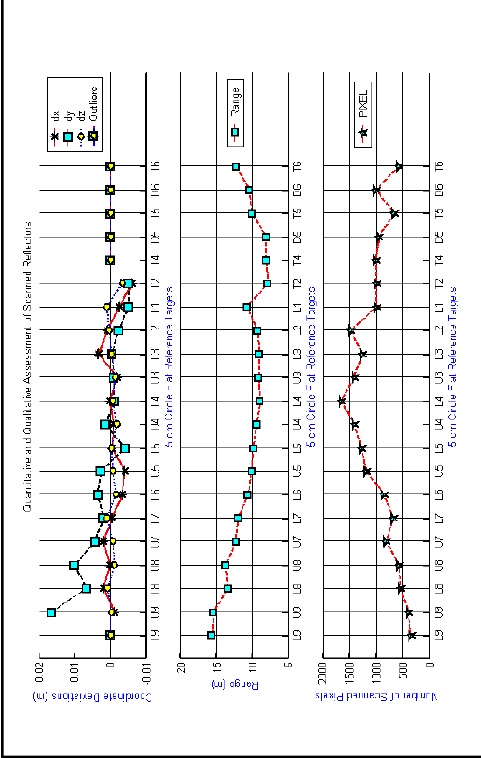
Figure 6: Accuracy and its relation at Station